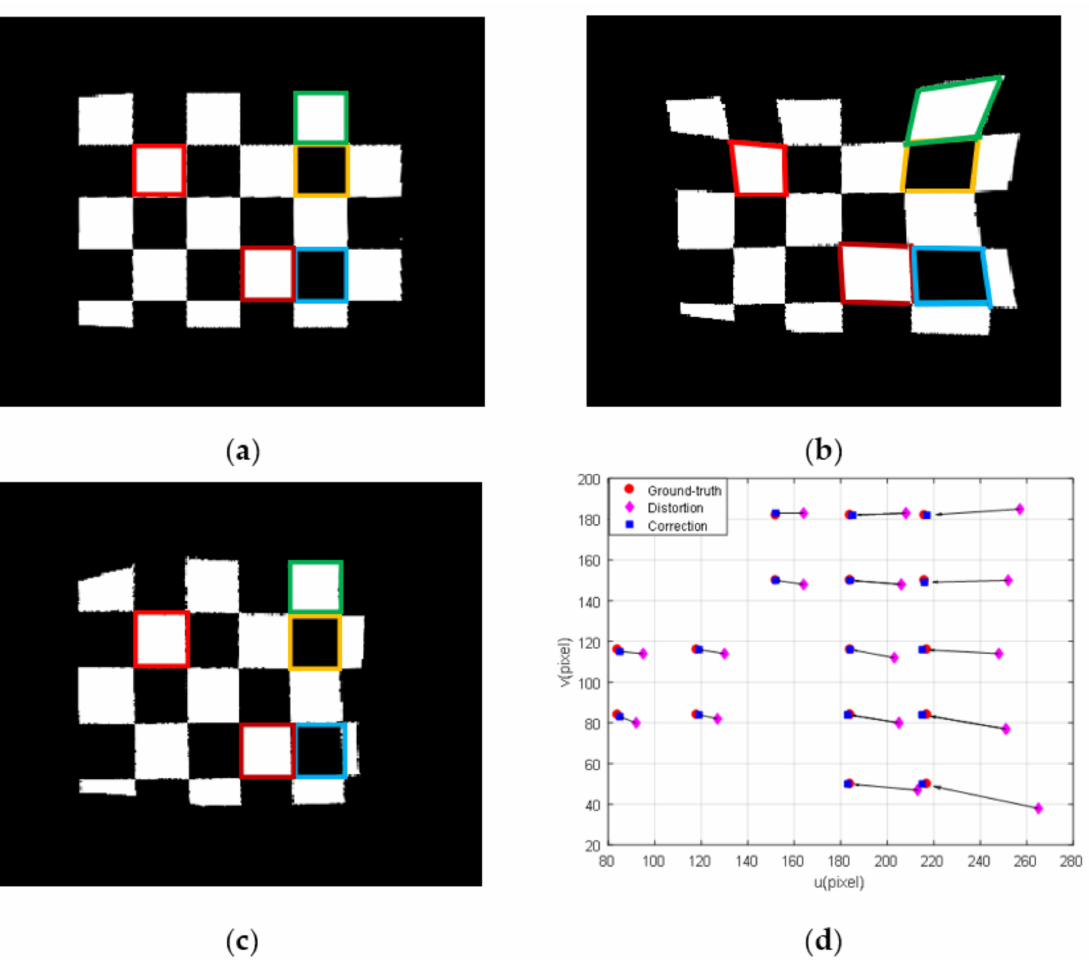
Figure 15. ( a ) Ground-truth image; ( b ) an image distorted by a wavy WAI; ( c ) recovered image; ( d ) a scatter plot showing coordinates of the corner points of the color-coded square checkerboards in above three images.